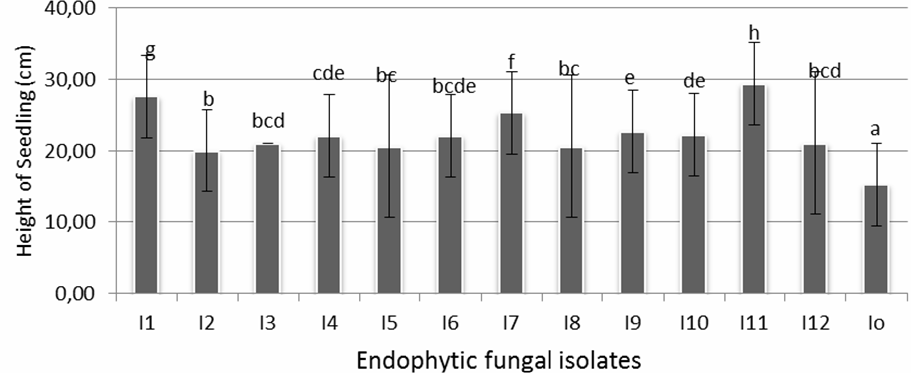
Fig. 2. The influence of endophytic fungal isolates on rice seedling growth (height)